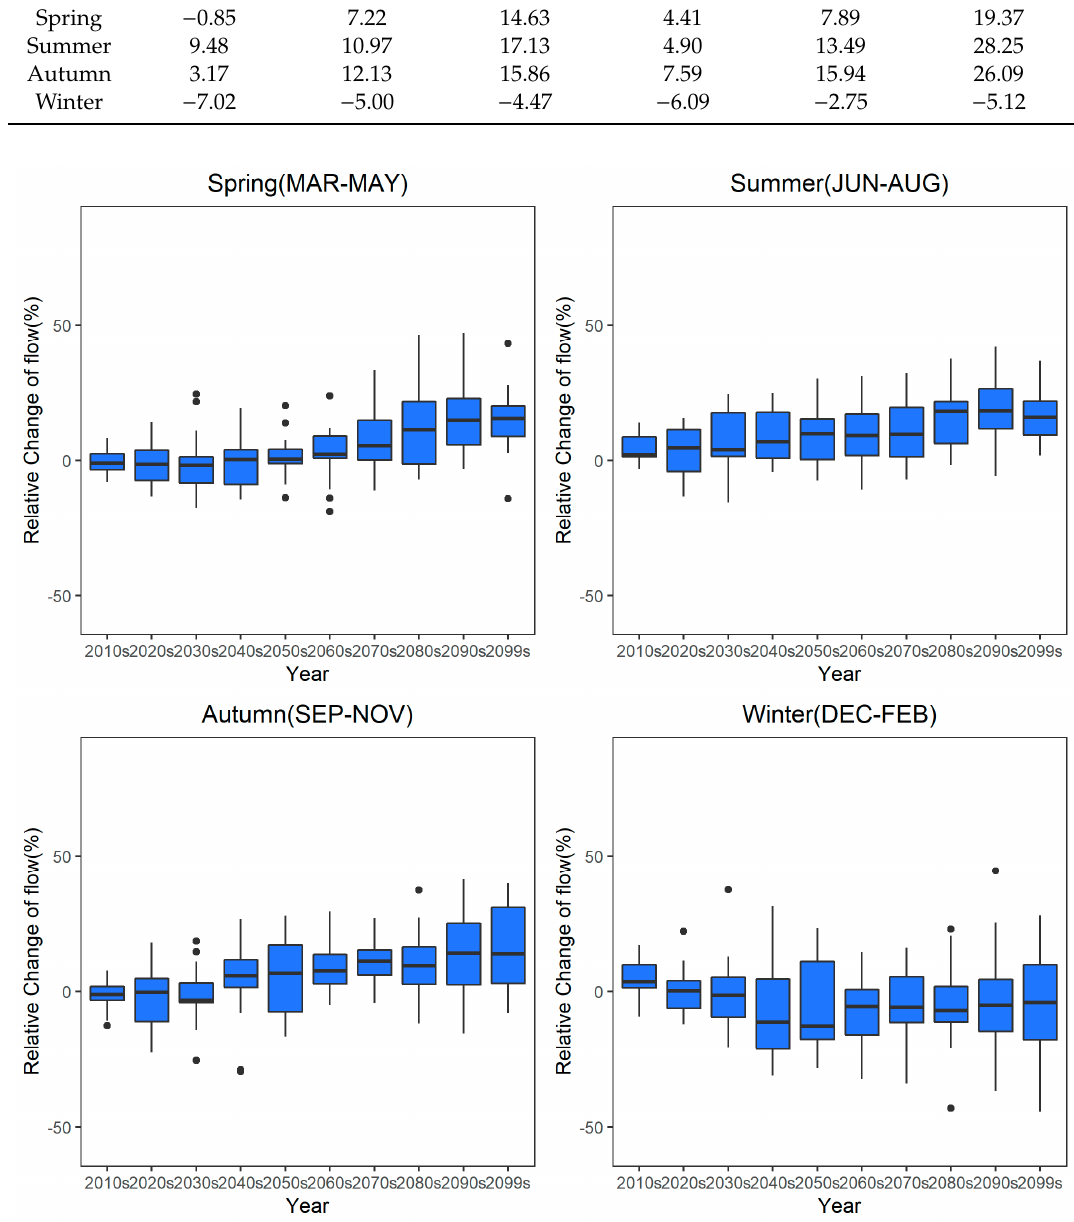
Figure 6. Relative change (%) of the 30-year moving average seasonal flow compared with the reference period (1976–2005) for RCP 4.5 using 13 GCMs in South Korea. The values were calculated by first converting the daily flow data into seasonal flow data. Next, the relative change of the 30-year moving average seasonal flow for 13 GCMs was calculated and is shown as a box plot.